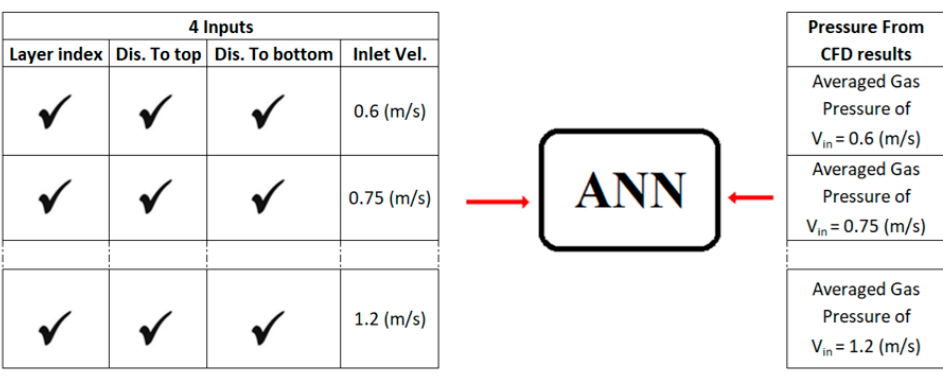
Figure 30. Traning for average gas pressure using four static parameters at layer level at each time step.